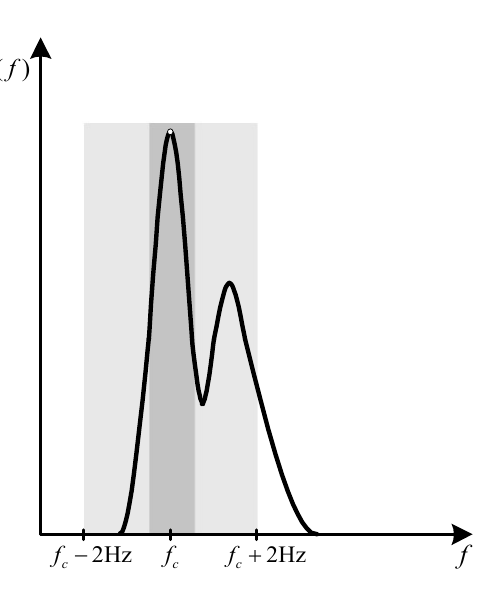
Figure 6. Spectrum of the tremor signal measured by a triaxial gyroscope.